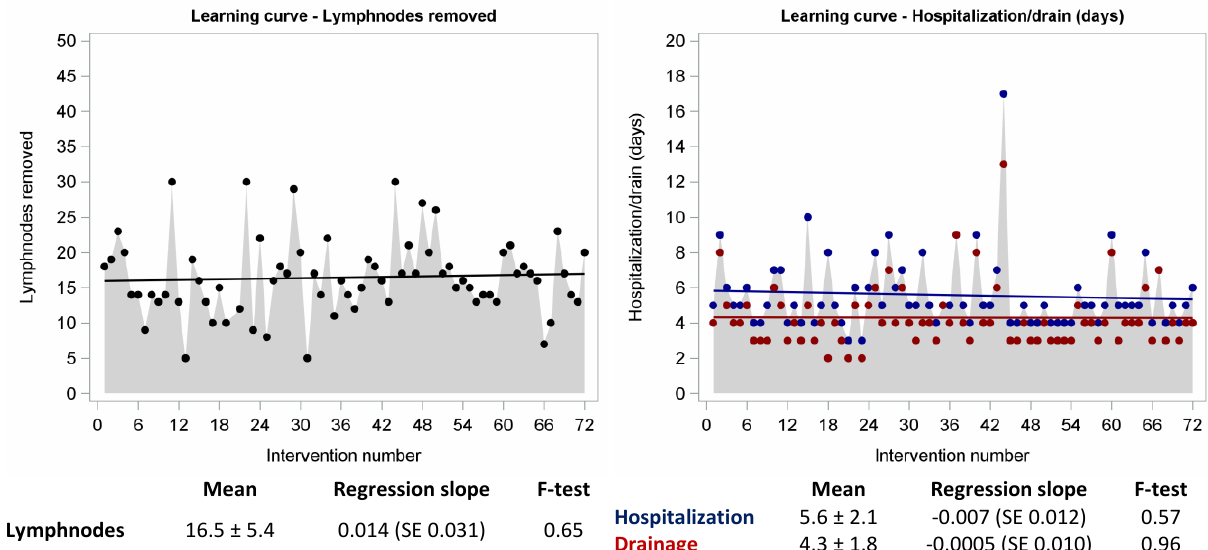
Figure 4. Number of harvested lymph nodes and length of hospitalization/drainage in patients who underwent robotic-assisted lobectomy.